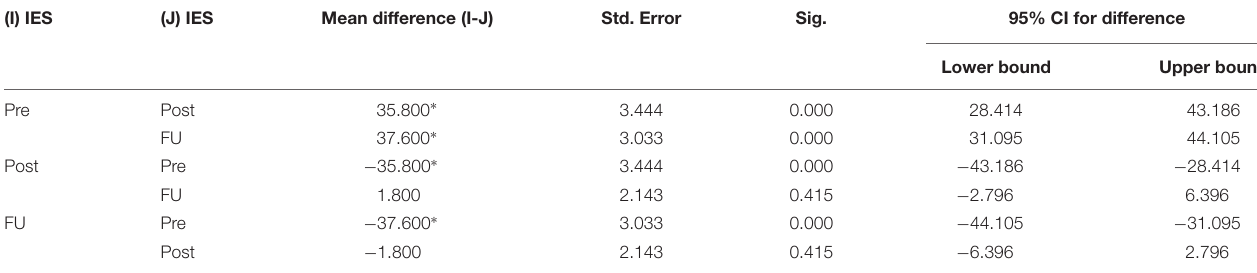
∗ Indicates significant difference between pairs.